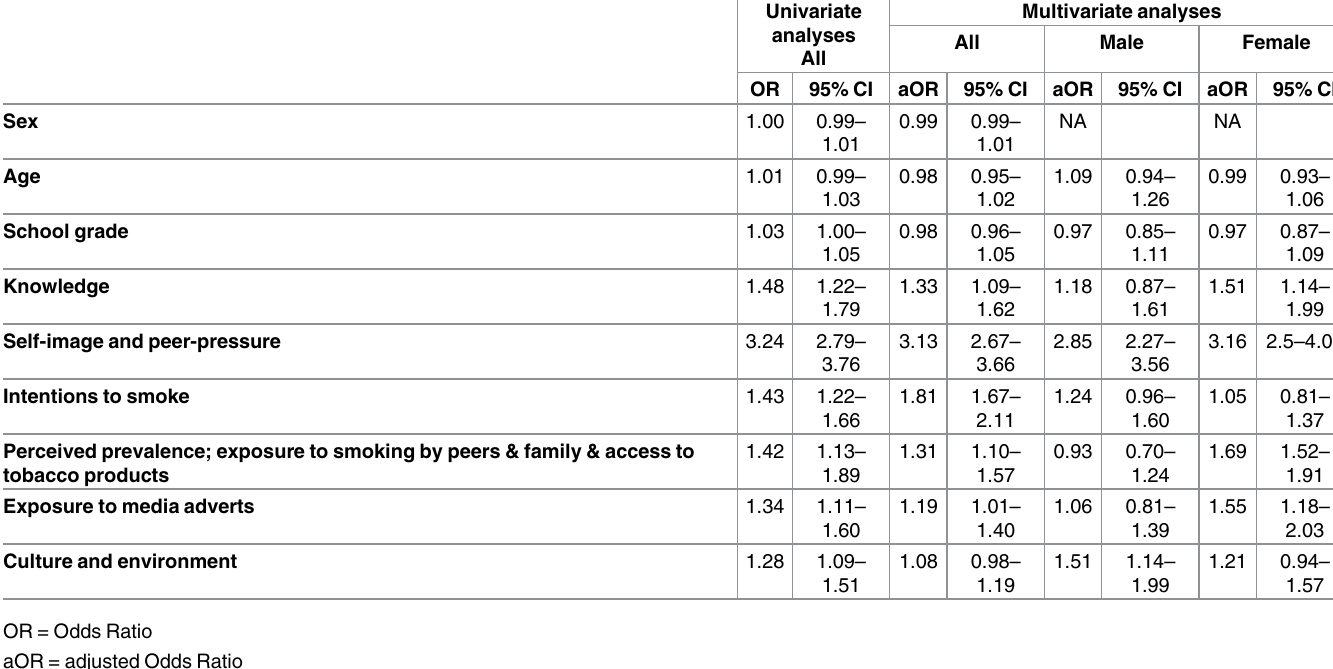
Table 3. Univariate and multivariate analysis of risk factors associatedwith